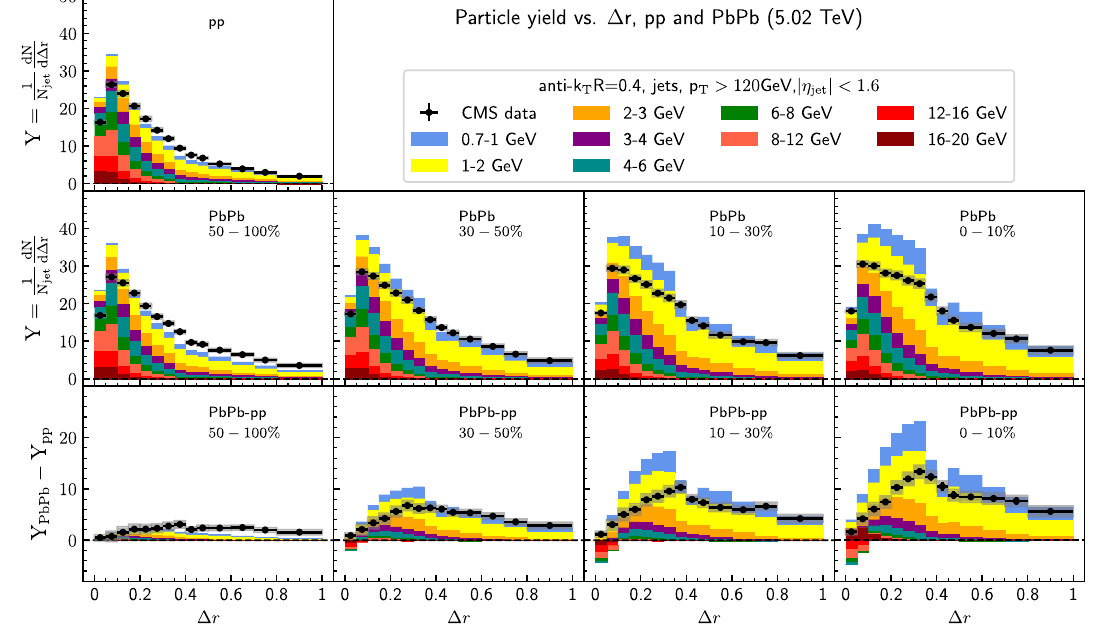
Fig. 6 Jet-correlated charged particle yield distribution as a function histograms are obtained from the AMPT model: different colors repre- of (cid:2) r in p + p (top left panel), Pb + Pb (middle panels) collisions and sent the contributions from different p T intervals for charged particles. their differences (lower panels). Four different Pb + Pb collision cen- The accumulated histogram for 0 . 7 < p T < 20 GeV is compared to tralities are shown: 0 − 10% , 10 − 30% , 30 − 50%, and 50 − 100%. Jets CMS data [66] > 120 GeV, R = 0 . 4 and | η | < 1 . 6. The stacked are taken with p jet jet T